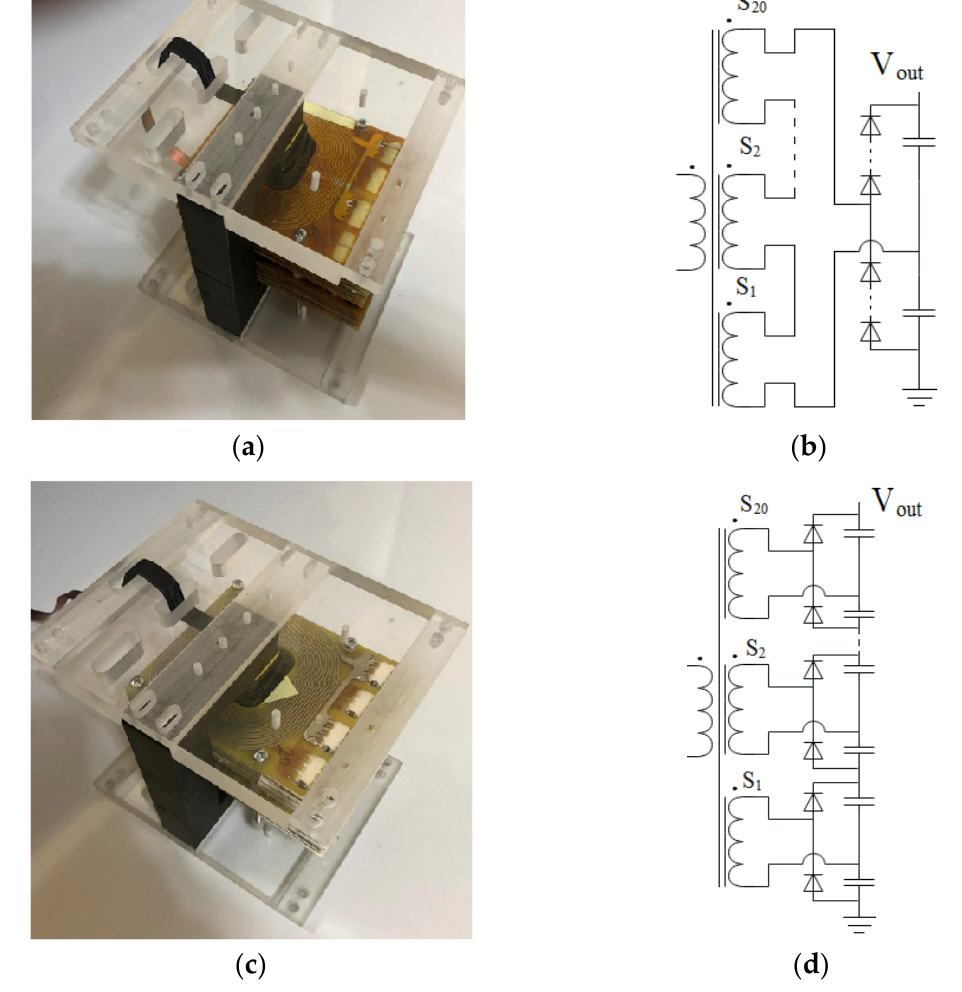
Figure 12. Prototype and connection diagram of TR1 (multi-layer) and TR2 (multi-winding): ( a ) prototype of TR1, ( b ) connection diagram of TR1, ( c ) prototype of TR2, ( d ) connection diagram of TR2. Table 1. Transformer prototype